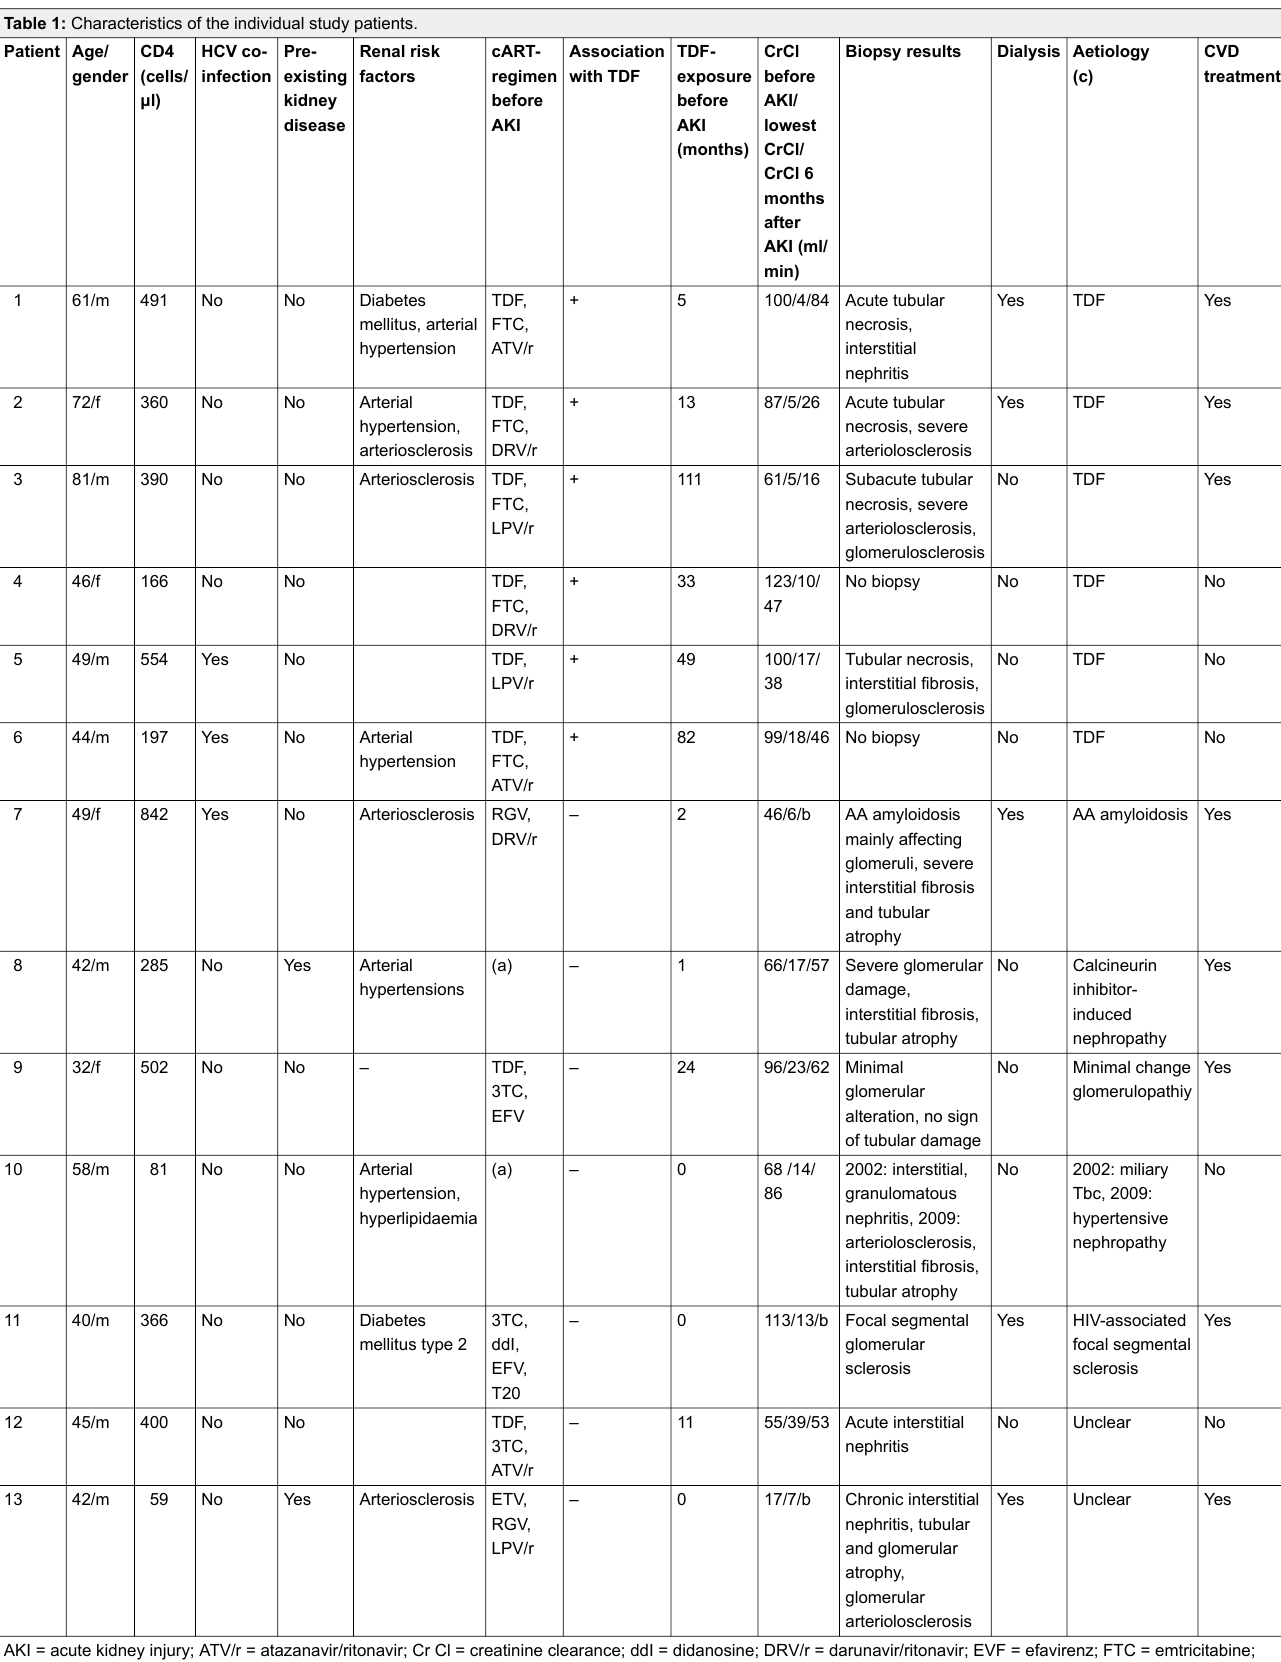
Table 1: Characteristics of the individual study patients. Patient Age/ CD4 gender